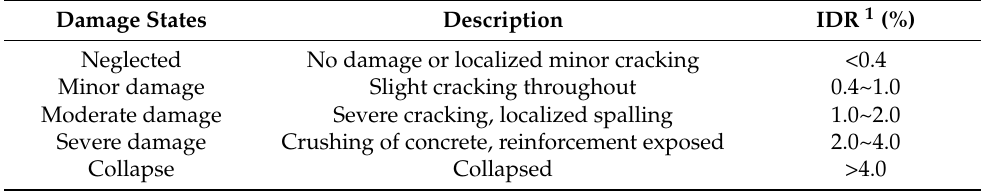
Table 1. Structural damage states corresponding to the interstory drift ratio (IDR) limit values. Damage